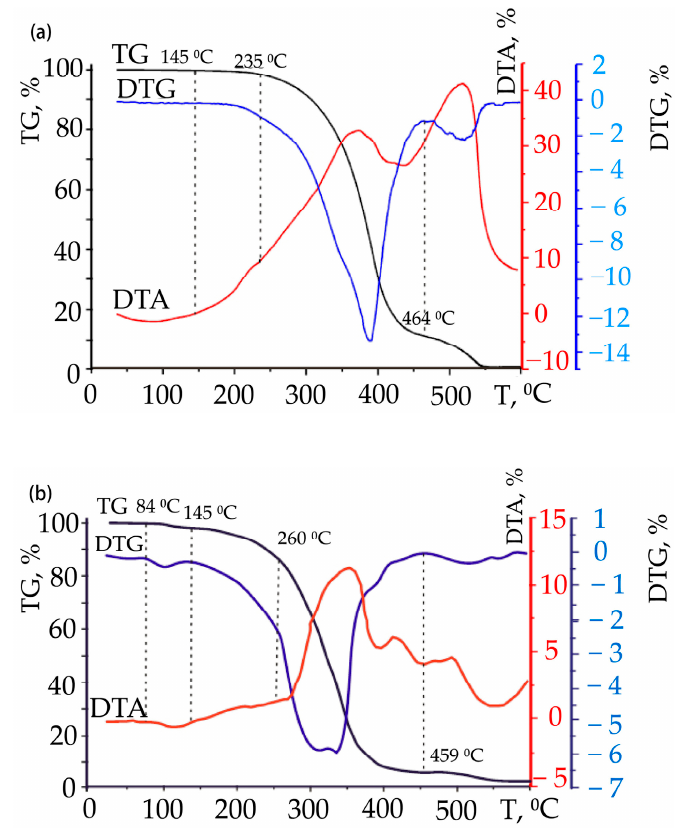
Figure 8. Thermograms of the sample LCL r ( a ) and sample LCL n ( b ).